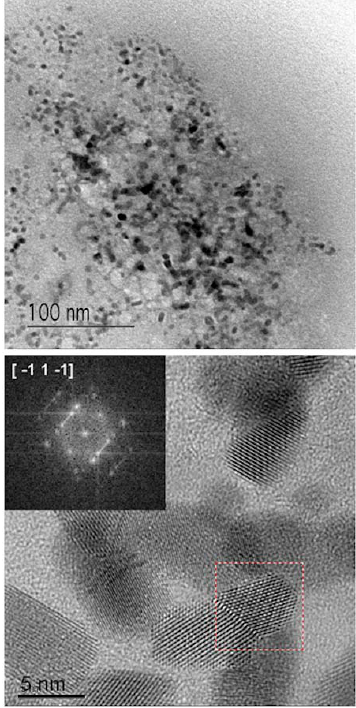
Fig. 4. (a) TEM bright field image of PbS-inclusions in a sulphate particle, and (b) HR-TEM bright field image and pseudo-diffraction pattern of the